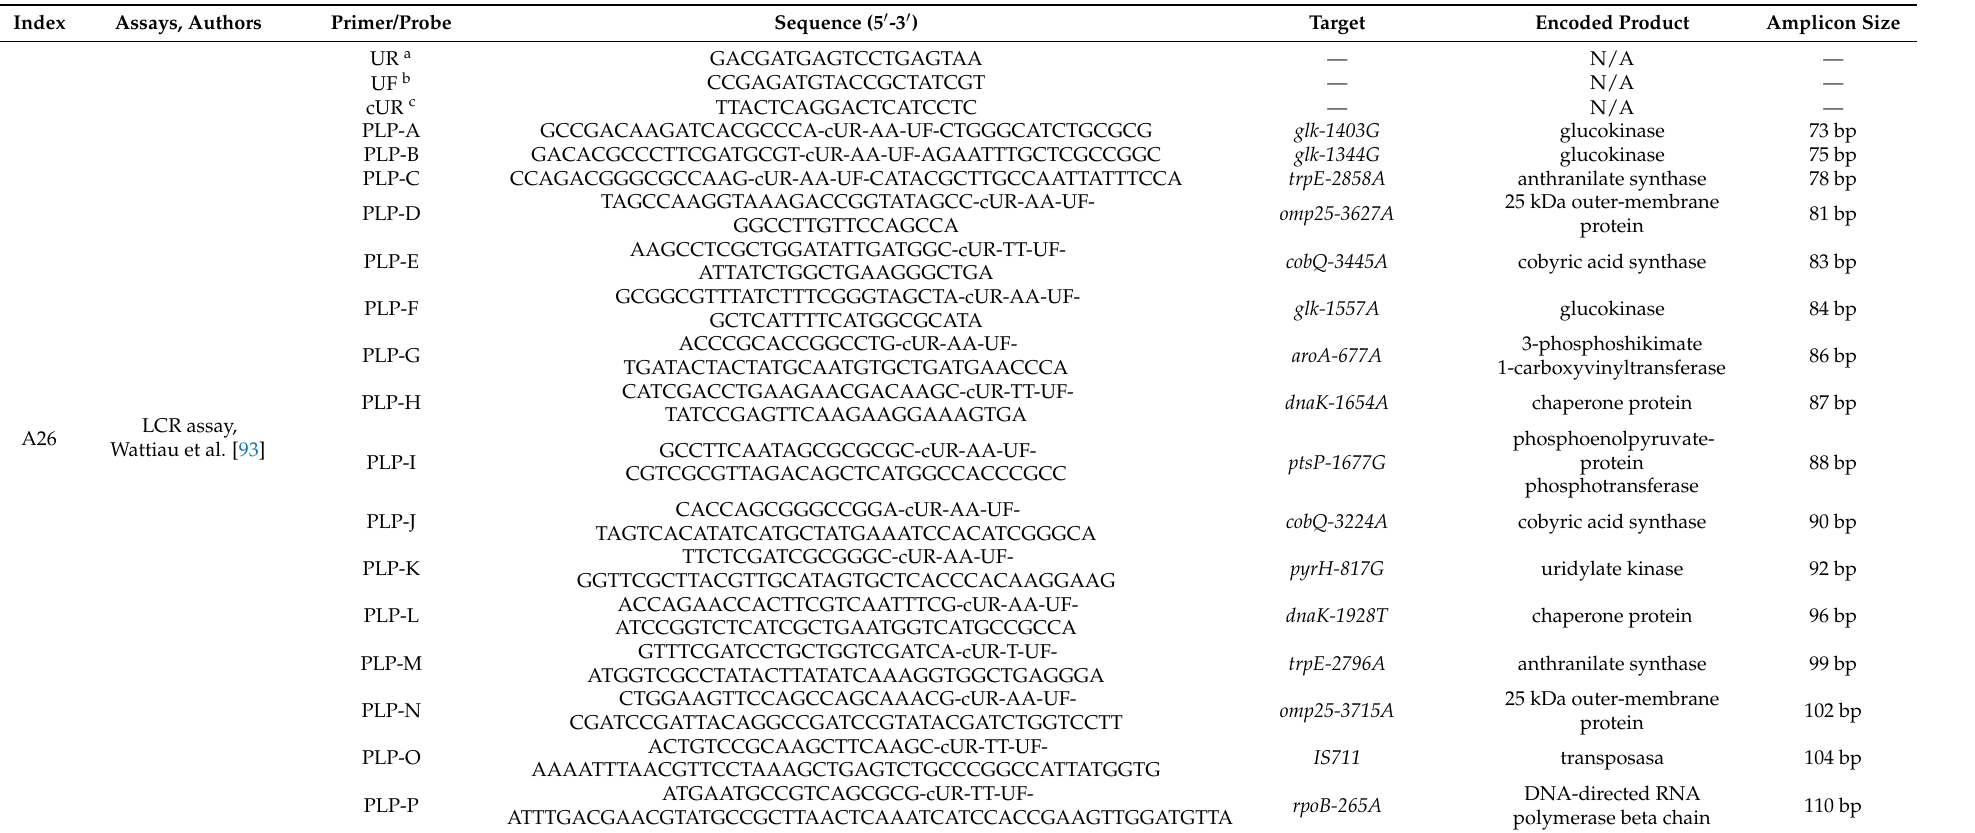
Table 5. Primers and padlock probes (PLP) from the reviewed LCR